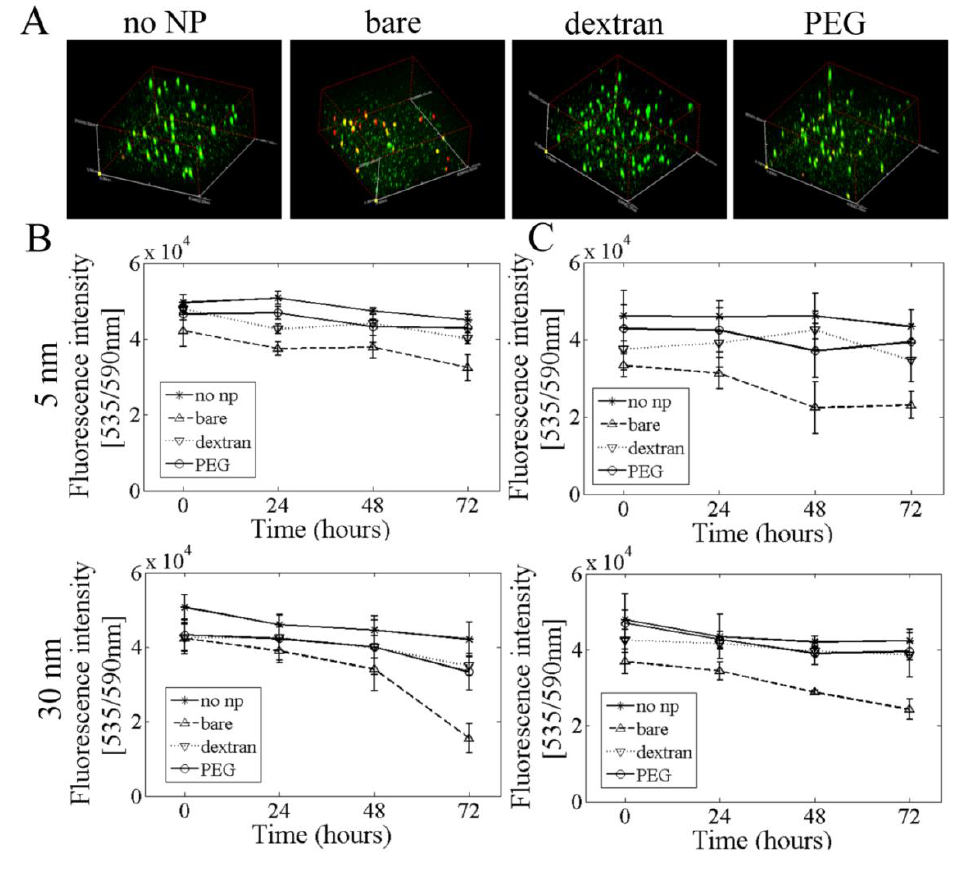
Figure 6. Dextran and PEG nanoparticle coating improved cell viability in 3D